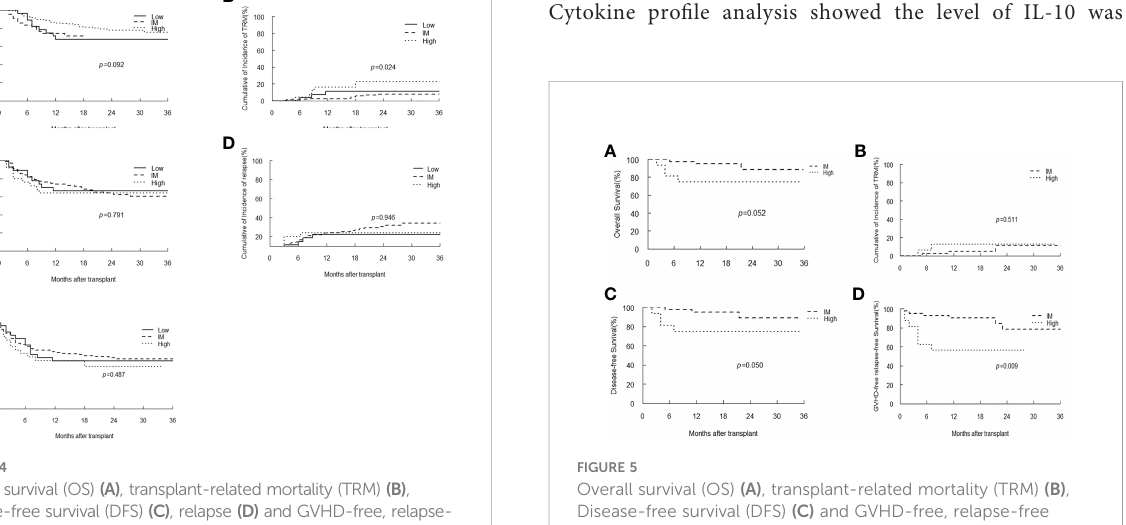
FIGURE 4 Overall survival (OS) (A) , transplant-related mortality (TRM) (B) , Disease-free survival (DFS) (C) , relapse (D) and GVHD-free, relapse- free survival (E) of malignant patients strati fi ed by EBV-level.